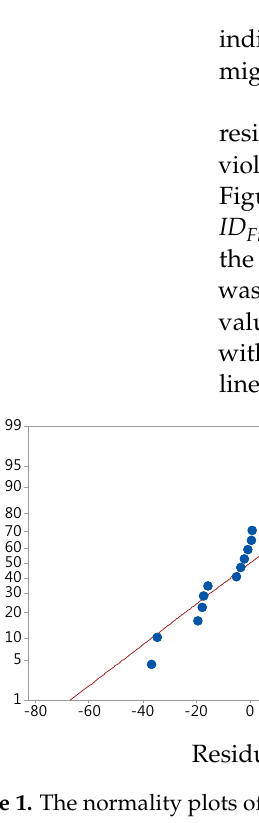
Figure 1. The normality plots of the residuals in the 1 oz stylus tapping task using the Canon model with ID Fitts . The left side is residual vs. response percentage in AD test; the right side is residual vs. ID Fitts . Both plot patterns show violation of the normality assumption.